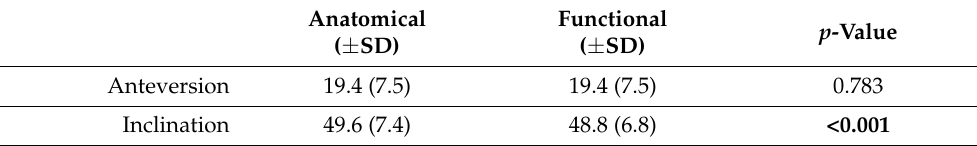
Significant differences are marked in bold. SD = standard deviation.